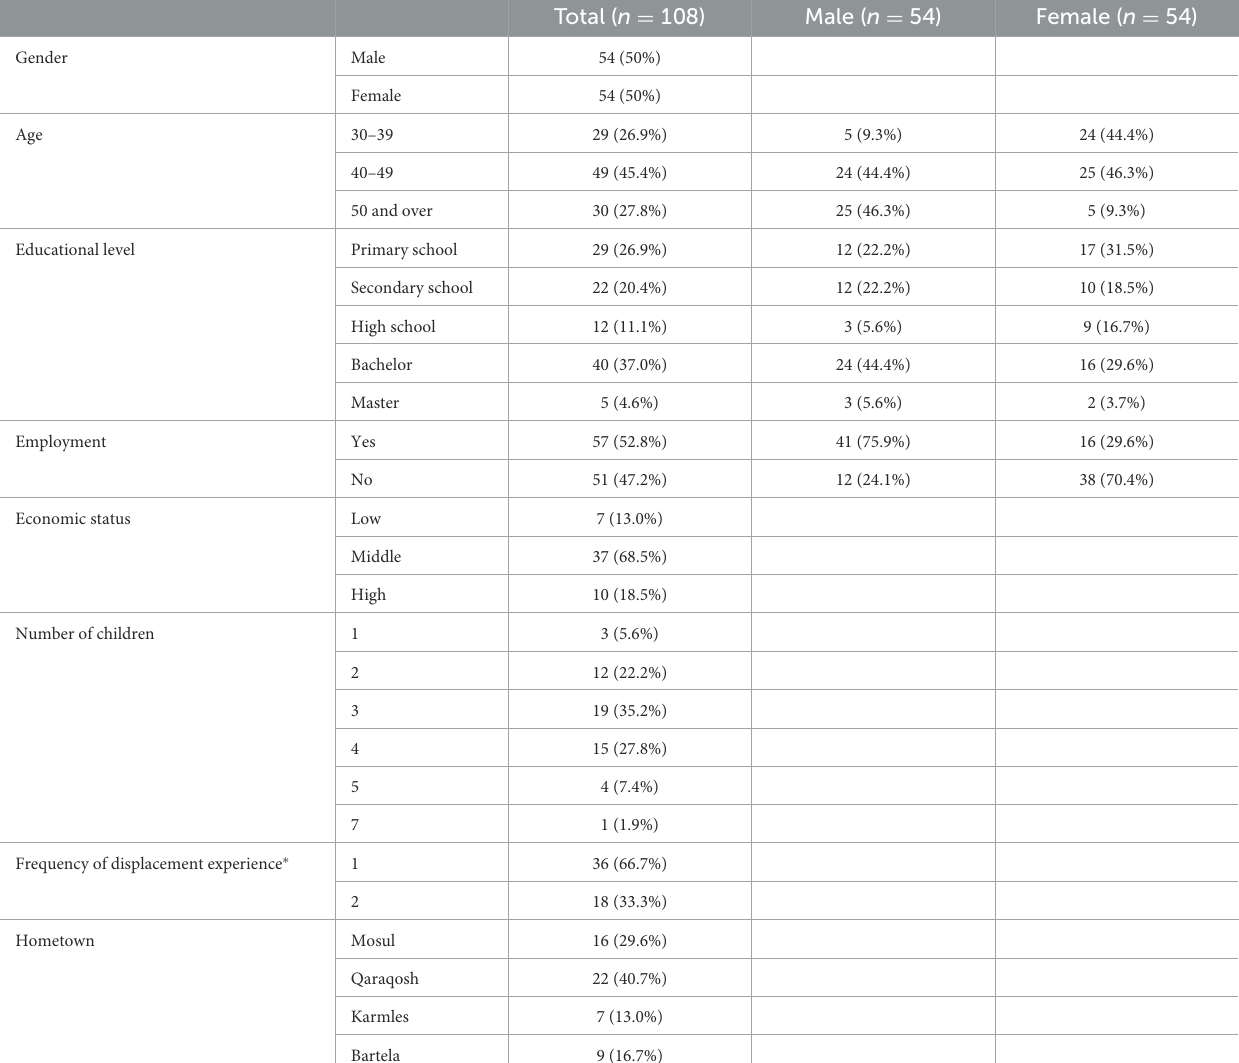
TABLE 1 Socio-demographic characteristics of the